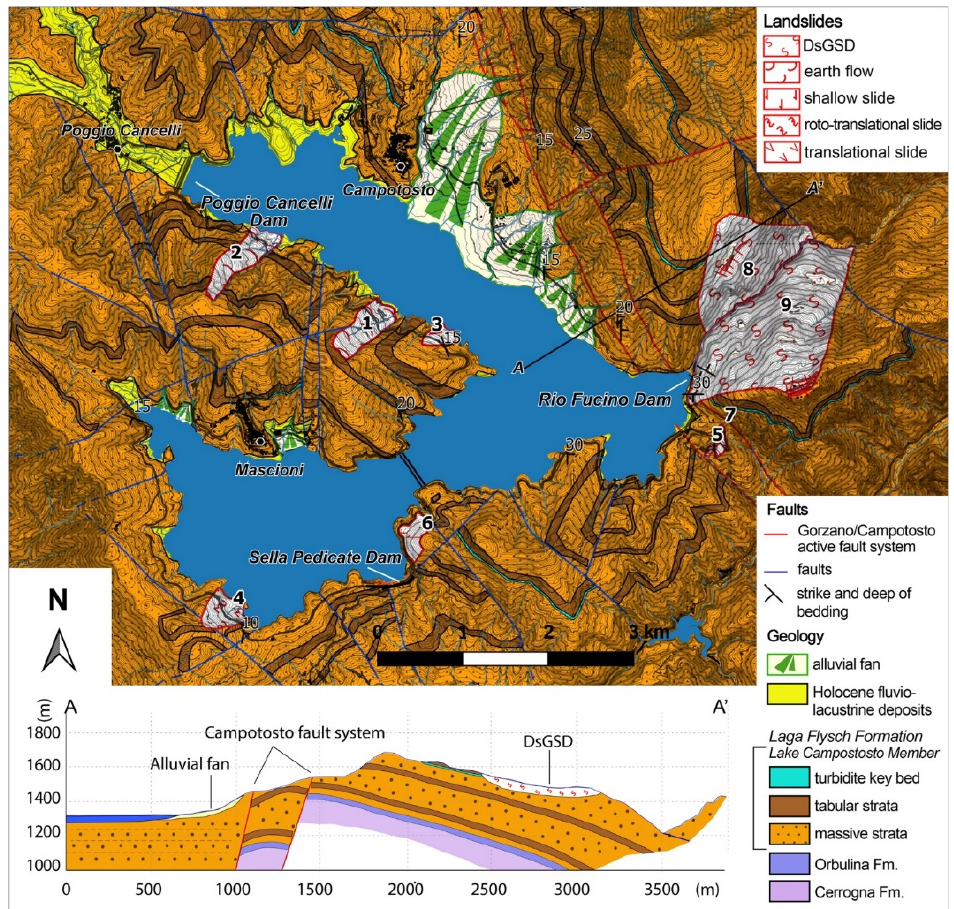
Figure 4. Geological and geomorphological map of the Lake Campotosto basin; section A–A’ across the active Campotosto fault system in the bottom panel.